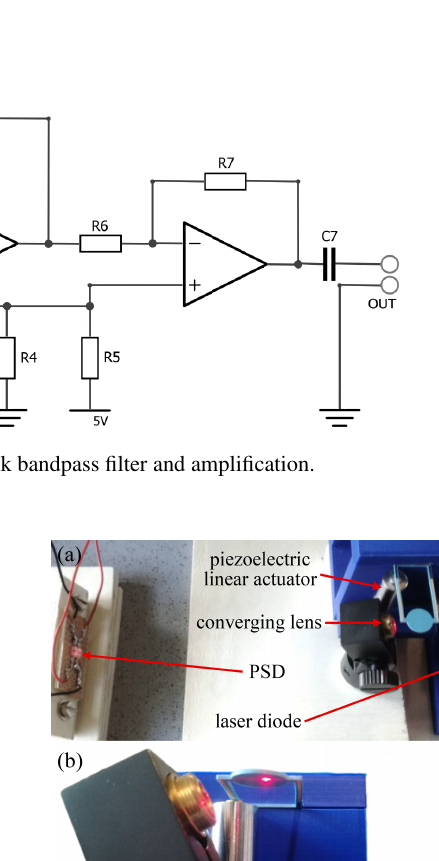
linear relationship can be seen. The sensitivity determined